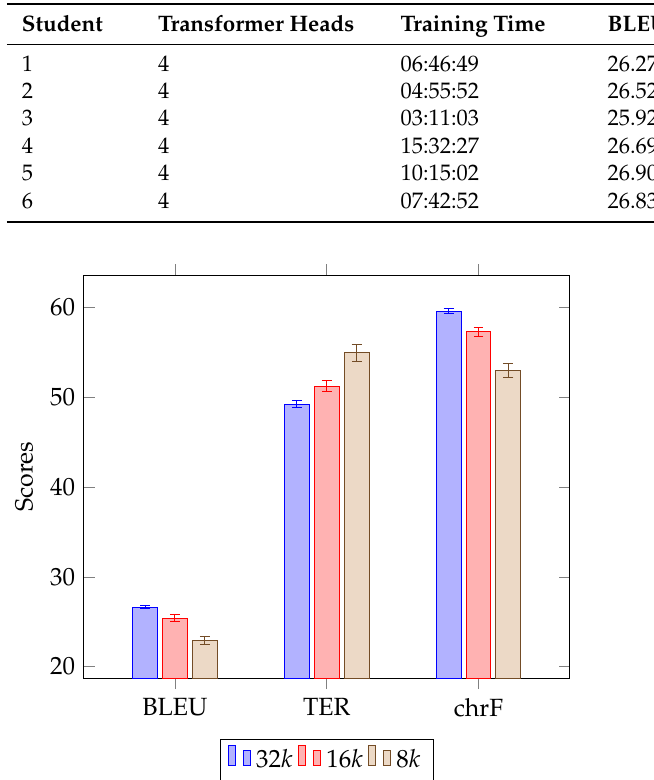
Table 7. Performance of the student models with 4 Transformer heads.